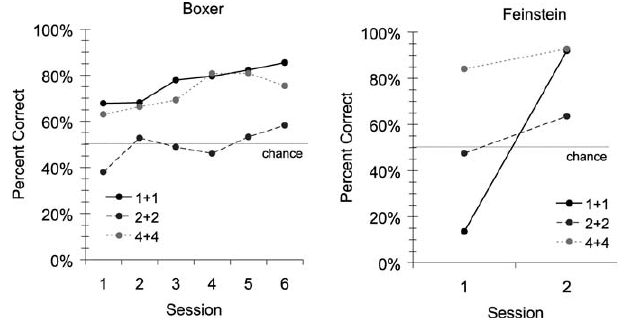
Figure 2. Monkeys’ Acquisition of the Addition Task Each session was approximately 250 trials, divided equally among the three problem types (1 þ 1, 2 þ 2, and 4 þ 4). Feinstein and Boxer required two and six sessions, respectively, to reach above-chance performance on all three trial types (binomial tests of accuracy versus chance: Boxer: 1 þ 1, n ¼ 62, 0.85 versus 0.5, p , 0.001; 2 þ 2, n ¼ 127, 0.58 versus 0.5, p , 0.05; 4 þ 4, n ¼ 61, 0.75 versus 0.5, p , 0.001. Feinstein: 1 þ 1, n ¼ 149, 0.92 versus 0.5, p , 0.001 ; 2 þ 2, n ¼ 184, 0.64 versus 0.5, p , 0.001; 4 þ 4, n ¼ 167, 0.93 versus 0.5, p , 0.001).